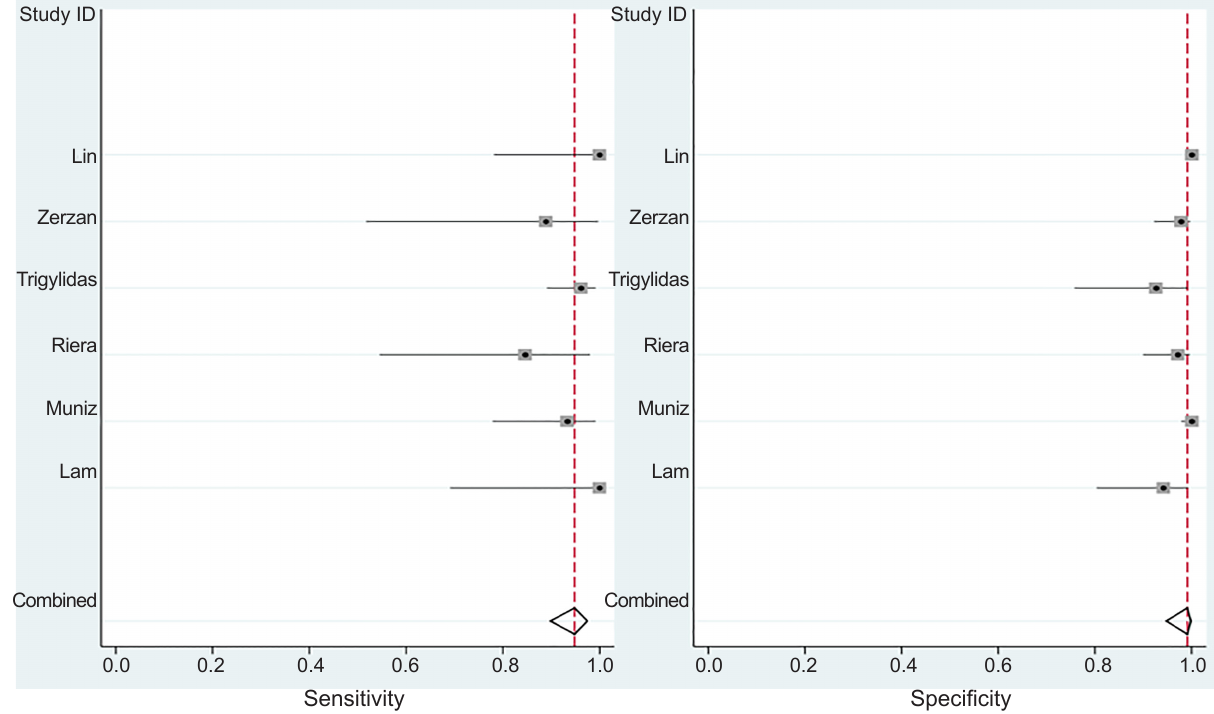
Figure 2. Forest plot with all included